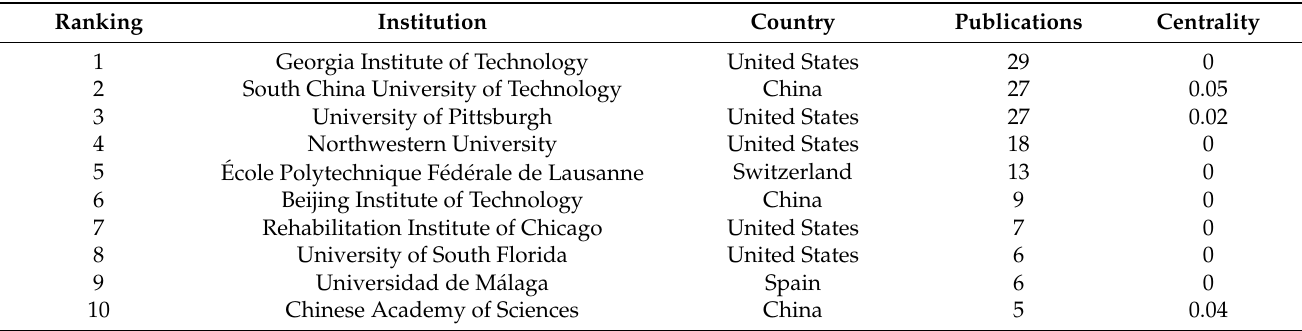
Table 4. Top 10 institutions involved in EPW HMI methodology